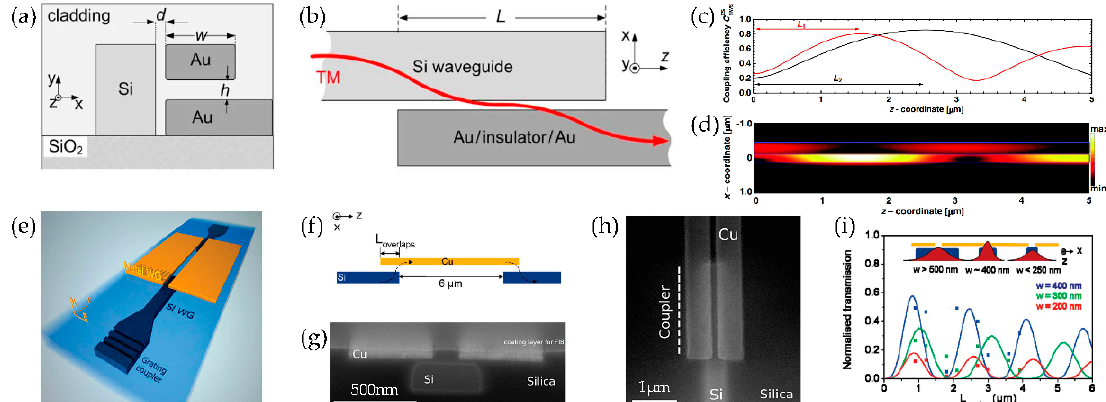
Figure 11. Directional coupling between silicon waveguides and metal–insulator–metal plasmonic waveguides. ( a ) Cross- section and ( b ) top views of a horizontally spaced directional coupler, of which the coupling efficiency and field distribution are shown in ( c , d ), respectively. ( e ) Perspective and ( f ) side views of a vertically spaced directional coupler, of which the SEM cross-section view, top view, and normalized transmission are shown in ( g , h , i ), respectively. Figures reproduced from ( a – d ) [150]; ( e – i ) [151].